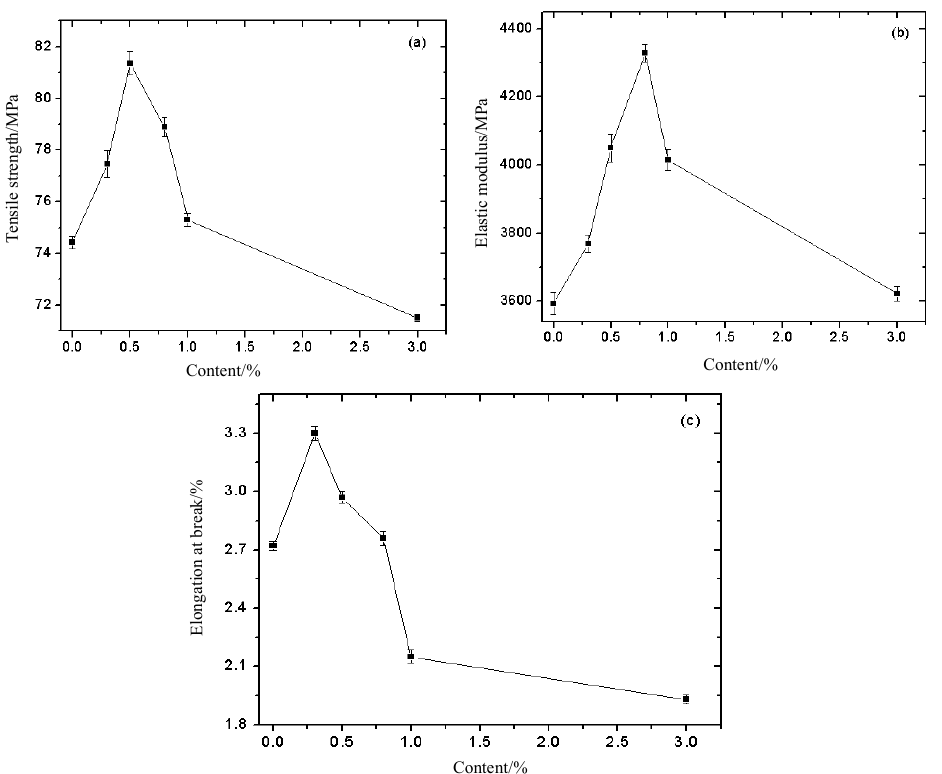
Figure 5. The mechanical properties of PLLA with different N-(benzoyl) stearic acid hydrazide